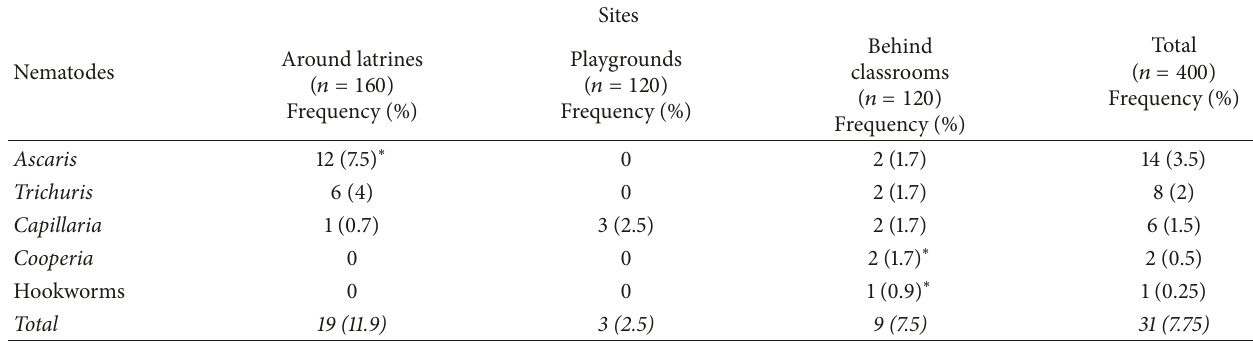
Table 3: Type and frequency of nematode eggs found in soil samples per sampling sites.